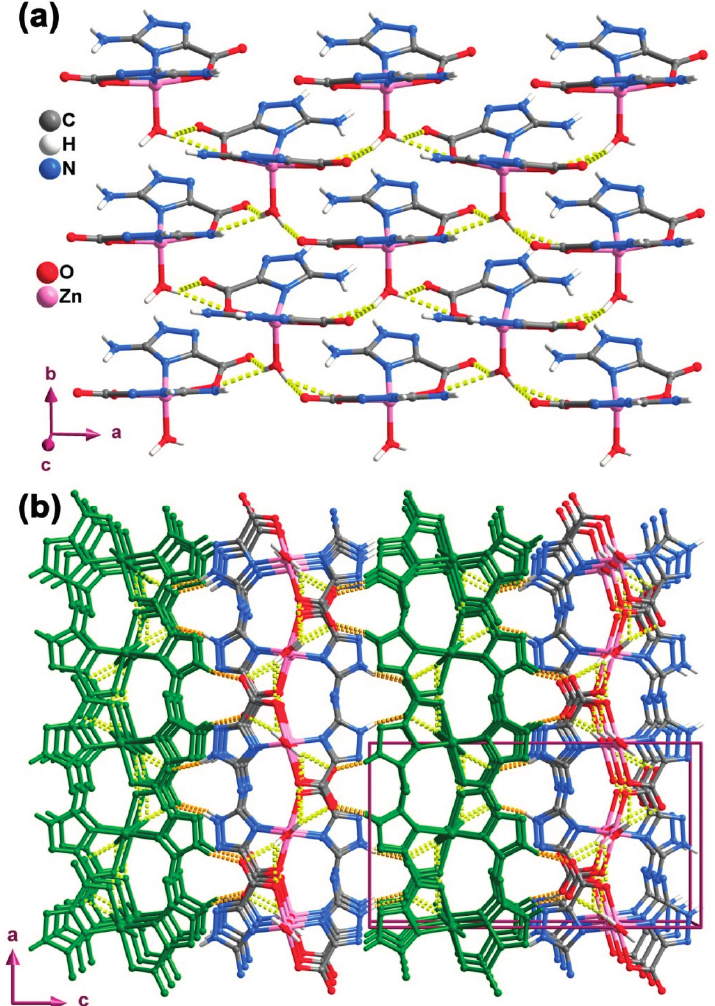
Figure 2. Ball-and-stick representation of ( a ) the 2D hydrogen-bonded network and ( b ) 3D hydrogen-bonded supramolecular network (layers with alternating colors) in the crystal structure of compound 1 . Hydrogen bonds are represented as yellow (those forming the 2D network) and orange (inter-layer connections) dashed lines. Geometric details on the represented interactions are listed in Table